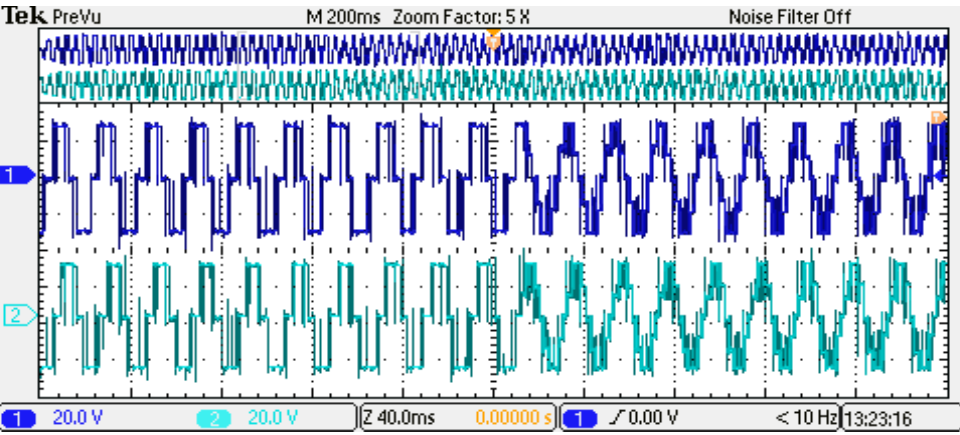
Figure 19. The experimental waveform of three–two-level modulation conversion.